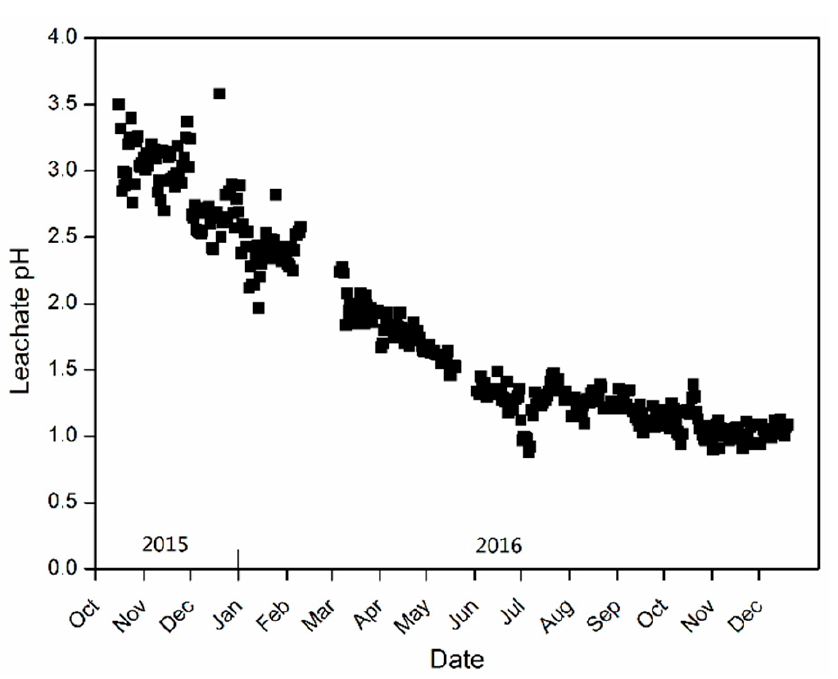
Figure 3. pH of the leachate from cell P3C6 during the heap bioleaching.